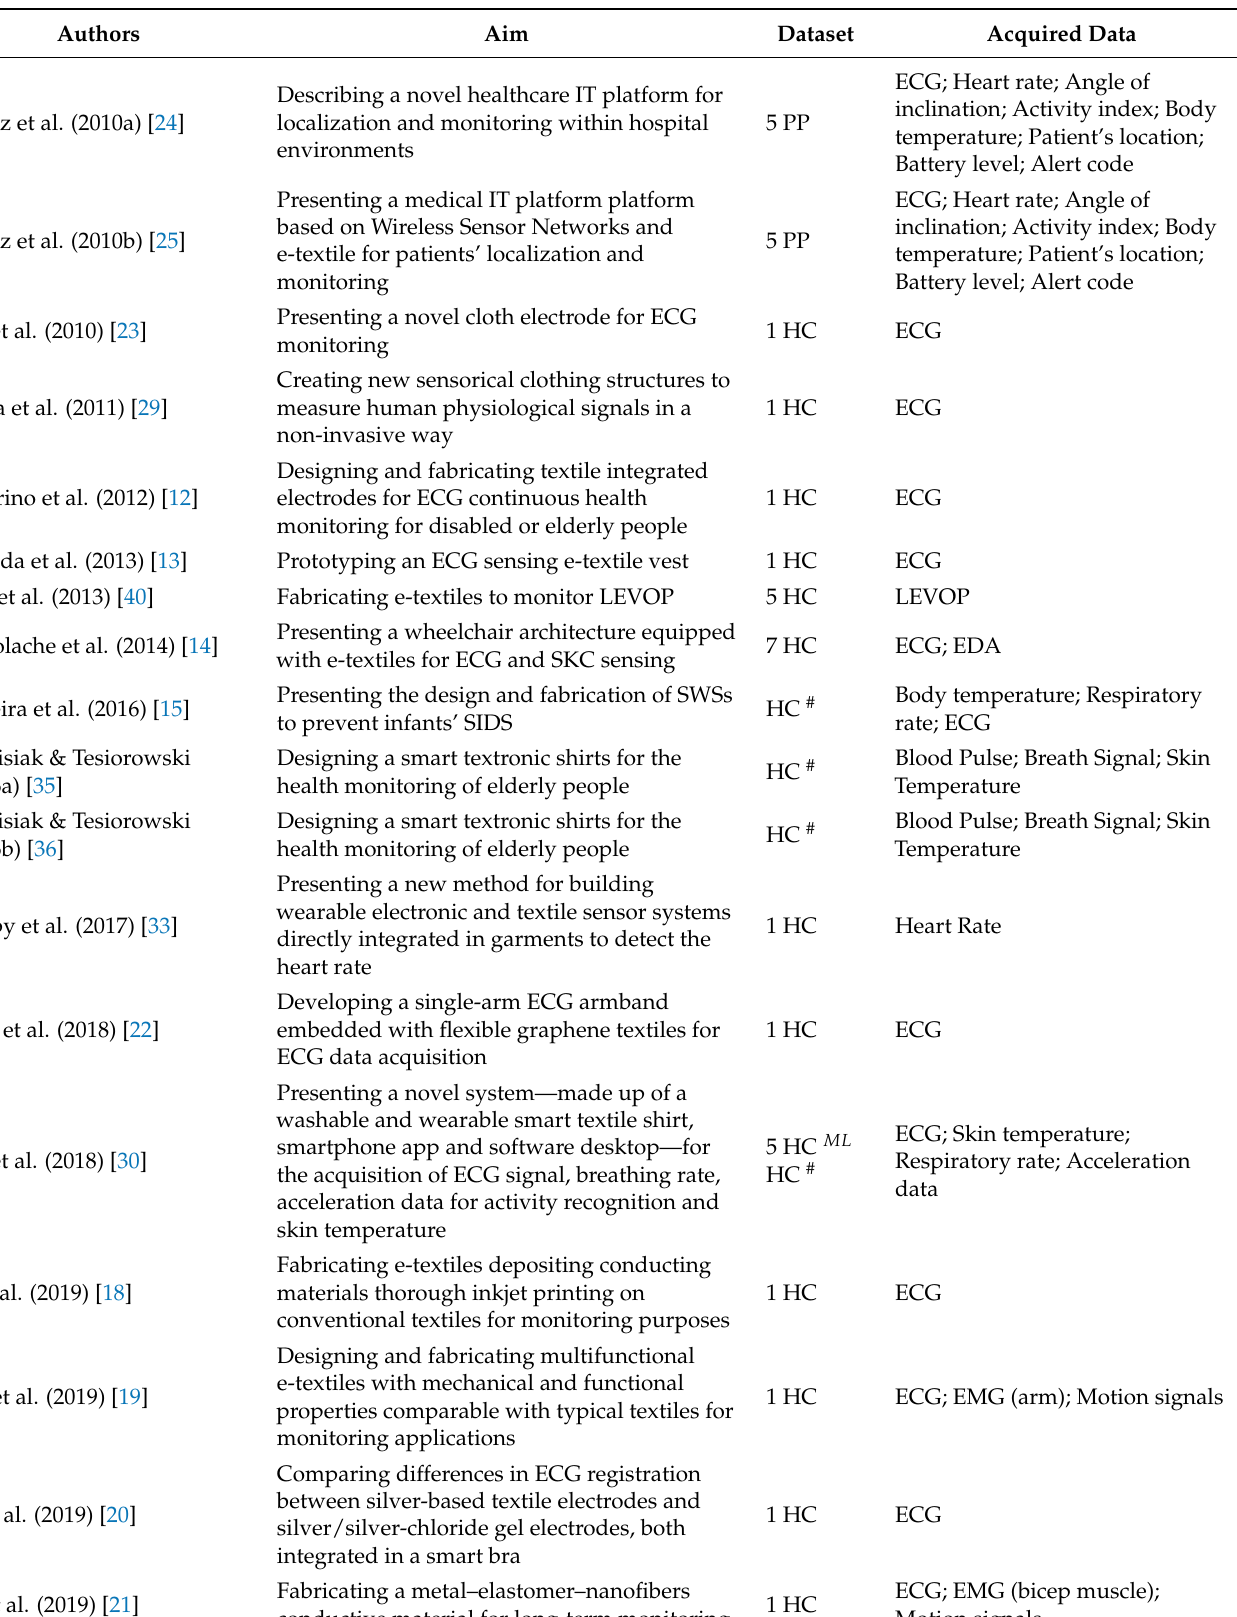
Table 2. Insights regarding cardiac literature: authors, aim, dataset, and acquired